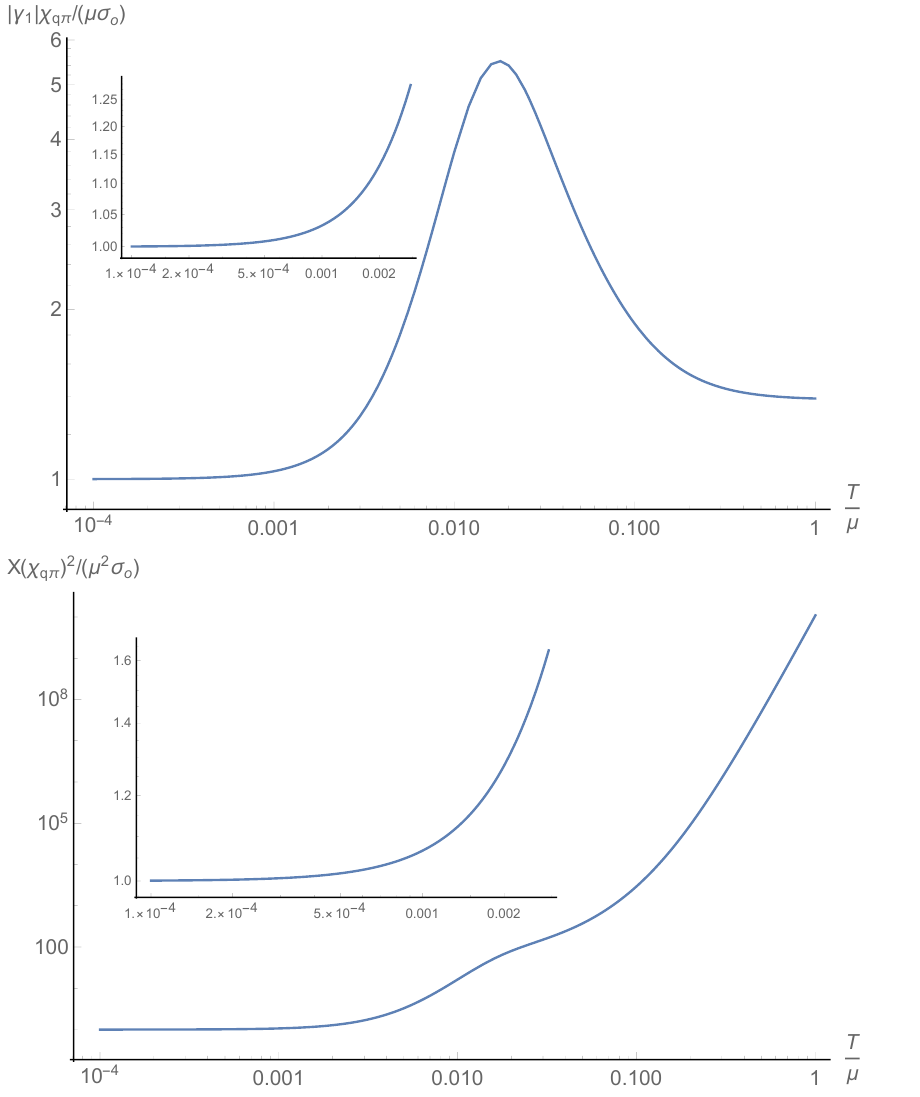
Figure 3 . At low temperatures, the entropy bound is saturated and the di(cid:11)usivities (cid:13) 1 , X are controlled by the thermal di(cid:11)usivity through